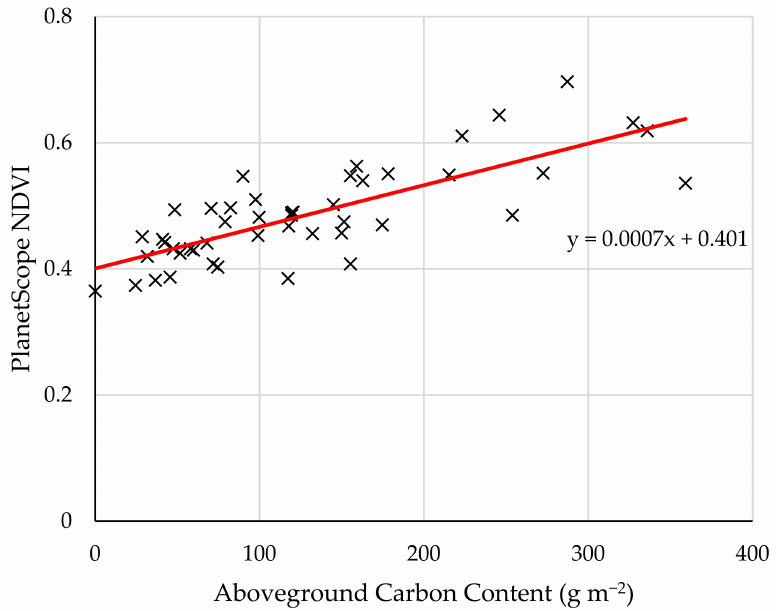
Figure 6. Relationship between aboveground carbon content extracted from the resampled 3 m map derived from the ArborCam image and PlanetScope NDVI captured on 23 October 2020 for all 47 quadrat locations (r = 0.78, p <